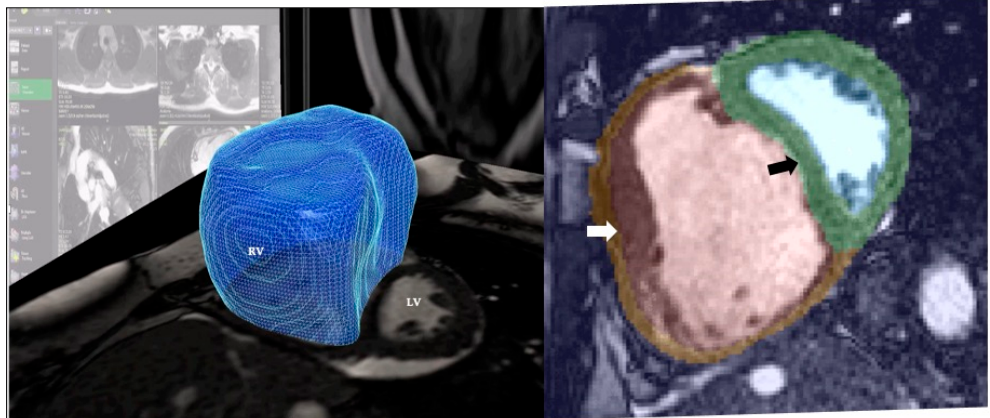
Figure 11. Example of computational modelling for a patient with idiopathic pulmonary arterial hypertension. A 3-D model at end-diastole and end-systole is used to determine the direction and magnitude of systolic excursion at each corresponding anatomic point in the mesh by using a deformable motion model. A machine learning algorithm was applied to identify recurring patterns that enabled survival prediction. A reduction in both longitudinal basal motion and decrease in radial contraction in the septum and free wall were found to be associated with poor outcome. RV: Right Ventricle. LV: Left Ventricle. White Arrow: Marked RV hypertrophy. Black Arrow: Abnormal motion of interventricular septum. Images courtesy of Dr Timothy Dawes, Honorary Clinical Lecturer in the National Heart & Lung Institute, London, UK.